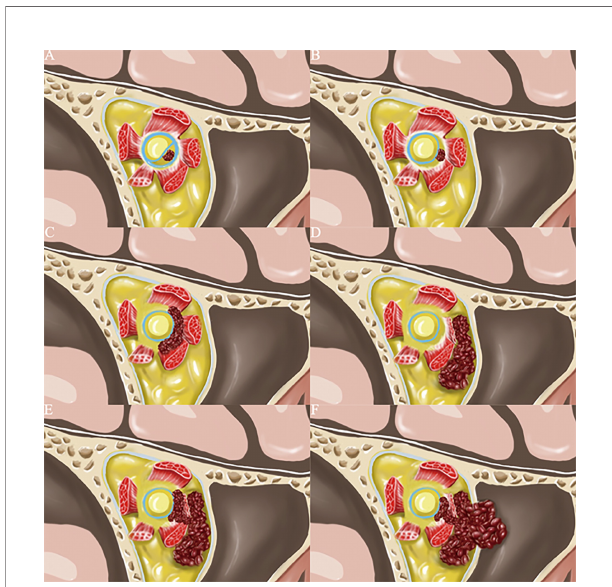
FIGURE 2 | According to the location of cavernous hemangioma in the orbit, we have drawn the 6 most common clinical types. (A) (Type I): The tumor is located under the optic nerve sheath near the optic canal in the orbital apex area. (B) (Type II): The tumor is located in the common tendon ring of the orbital apex region and not under the optic nerve sheath. (C) (Type III): The tumor is located inside the muscle cone of the orbit. (D) (Type IV): The tumor is located outside the muscle cone of the orbit. (E) (Type V): The tumor involved both the inside and outside communication region of the muscle cone. (F) (Type VI) The tumor involved both the inside and outside communication region of the orbit, and there is a little chance of breaking through the orbital periosteum.